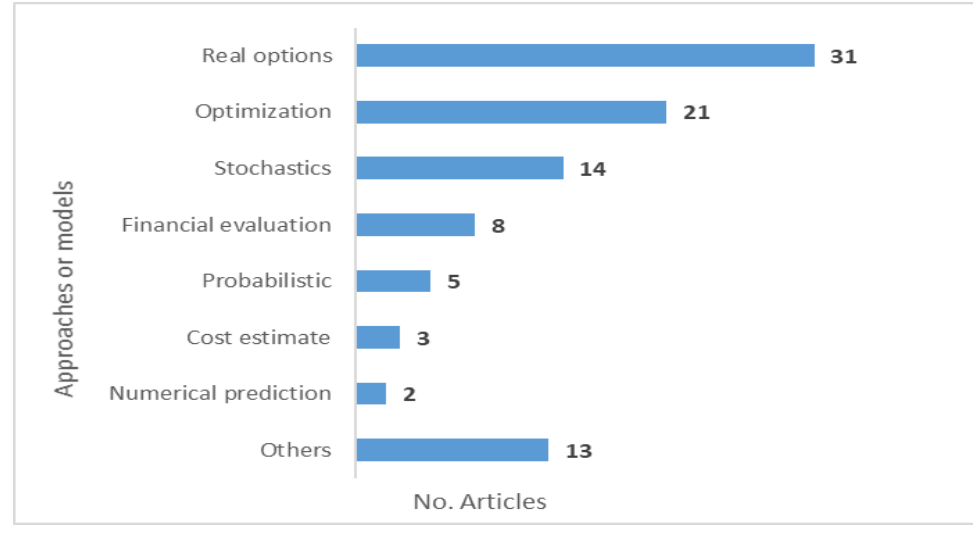
Figure 2. Categories of approaches or models used in the evaluation of investment in wind energy under uncertainty.